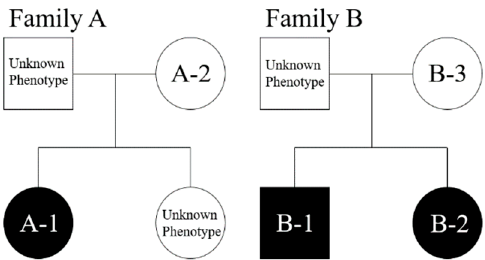
Figure 1. Family tree of Families A and B. Squares, male; circles, female; black background, individ- uals with dens evaginatus (DE); white background, individuals without DE.